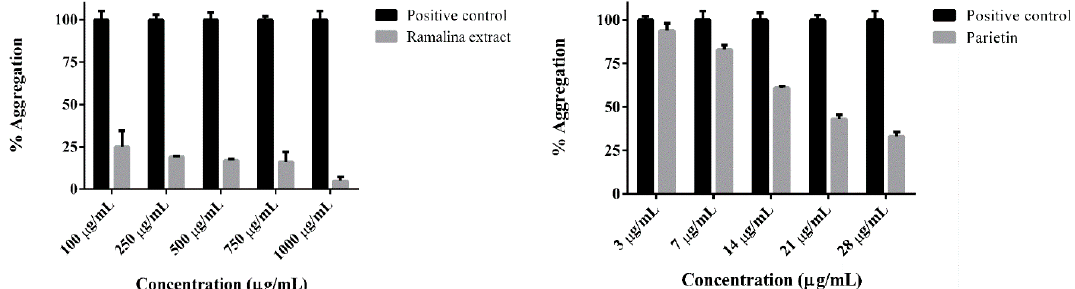
Figure 2. Tau aggregation process inhibited by both Ramalina extract and parietin. Black and grey bars represent positive control (aggregation) and inhibition respectively. A paired samples- t -test was conducted in order to compare control (aggregation) and tau inhibitors (Ramalina extract and parietin). There was a significant difference for both Ramalina extract t (4) = 25, p < 0.05 and parietin t (4) = 3.223, p < 0.05 (data are represented as Mean ± SEM).